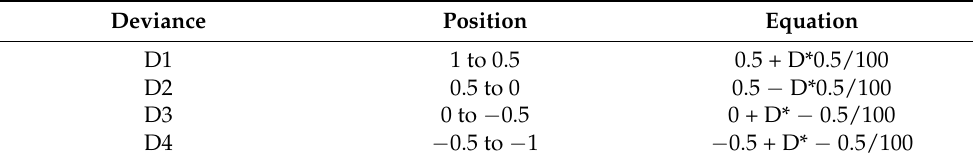
Table 4. Correspondence table for the computation of the intonation